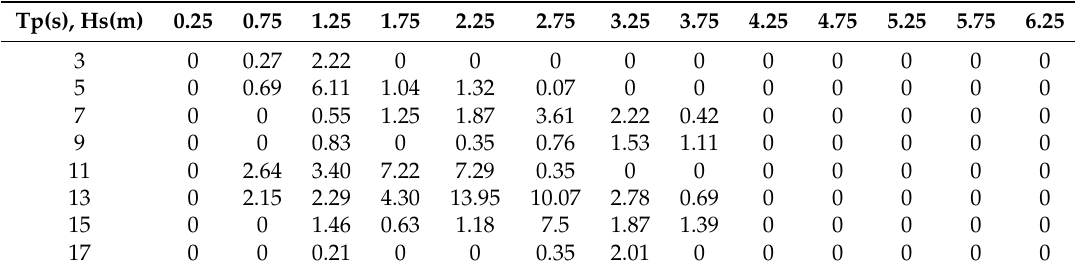
Table 4. Probability density (%) of waves according to significant wave heights and time periods for November 2009 at Orkney.